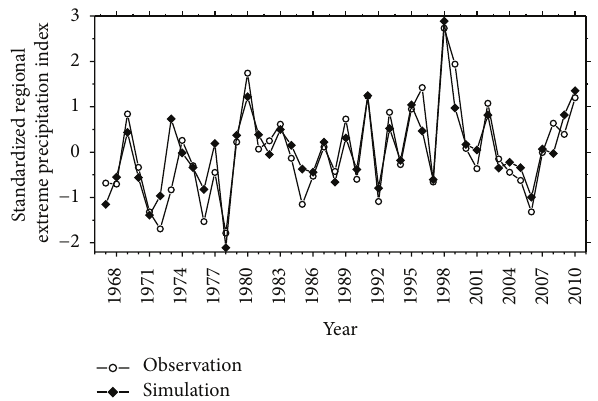
Figure 4: The time series of observed regional summer extreme precipitation index and corresponding model simulation results during the period of